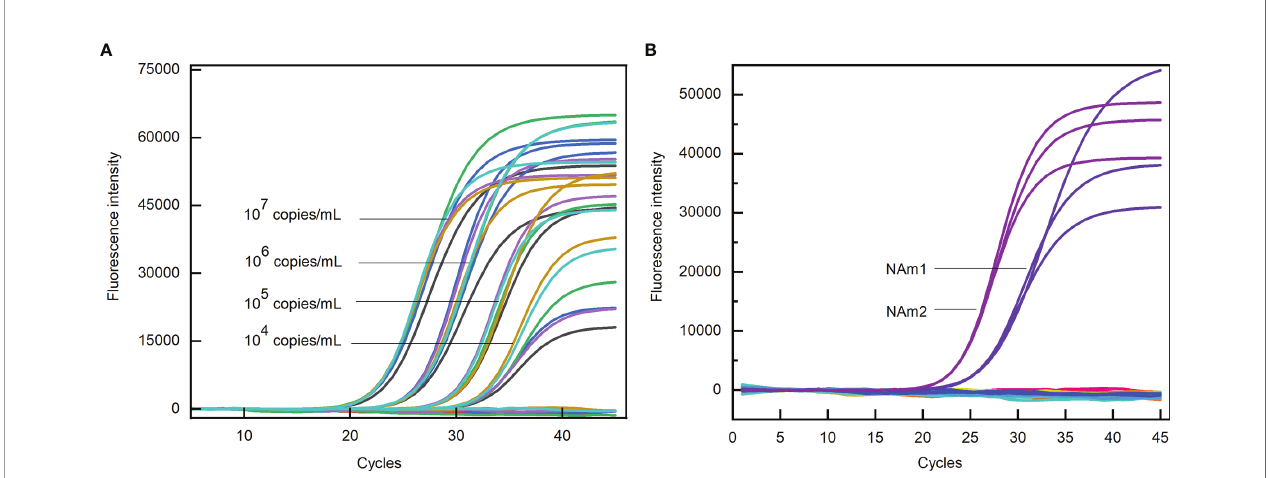
FIGURE 6 | (A) Sensitivity test of N anti-mutation (NAm) primers. The black, green, blue, cyan, orange, and purple curves represent US N1, N2, N3, CHN N, NAm1, and NAm2 primers, respectively. (B) Speci fi city test of NAm primers. The blue and purple curves represent the ampli fi cation curves of NAm1 and NAm2 when the SARS N gene was used as the template, and the fl at lines represent the ampli fi cation curves when the MERS-CoV, HCoV-229E, HCoV-OC43, HCoV-NL63, and HCoV-HKU1 N gene and human genome were used as templates.